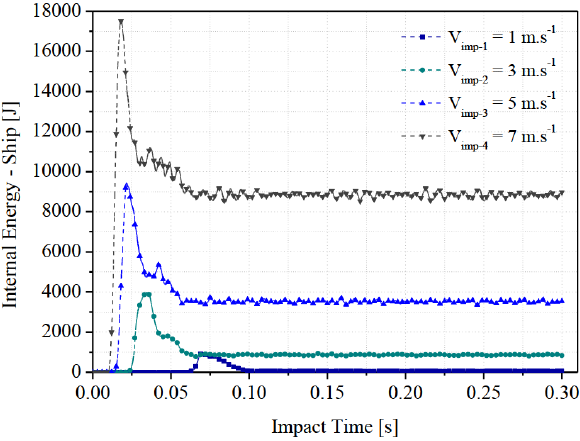
Figure 12: Internal energy of the ship structure during impact